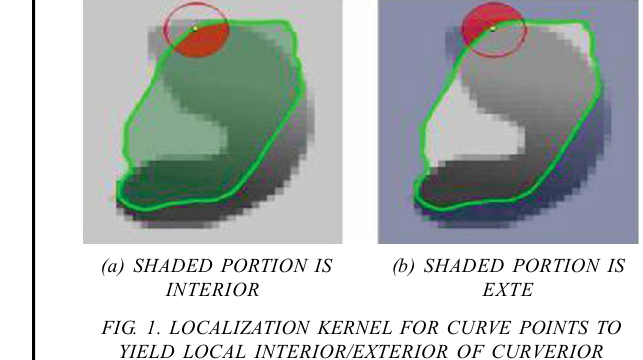
(a) SHADED PORTION IS (b) SHADED PORTION IS INTERIOR FIG. 1. LOCALIZATION KERNEL FOR CURVE POINTS TO YIELD LOCAL INTERIOR/EXTERIOR OF CURVERIOR